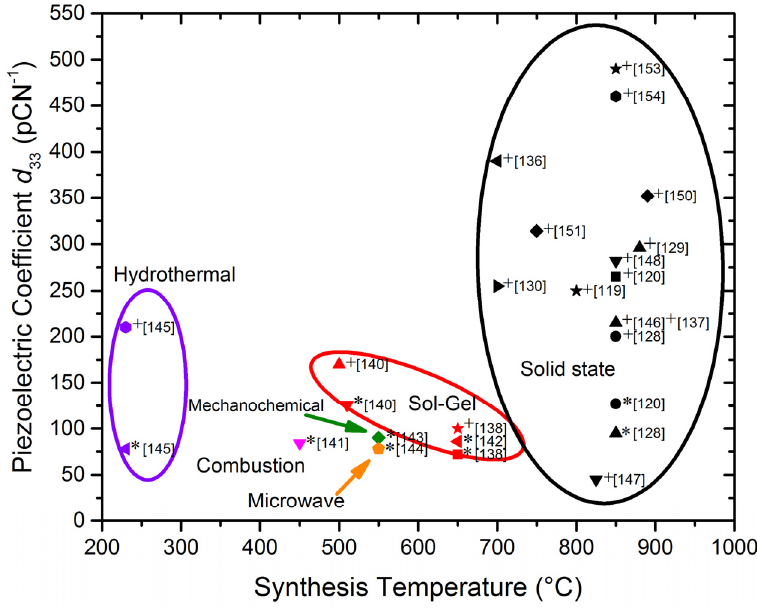
Figure 11. Piezoelectric coefficient d 33 vs . synthesis temperature for the different methods of KNN ceramics preparation, extracted from references in Table 3. ( * Pure KNN. + KNN ‐ based solid solution).